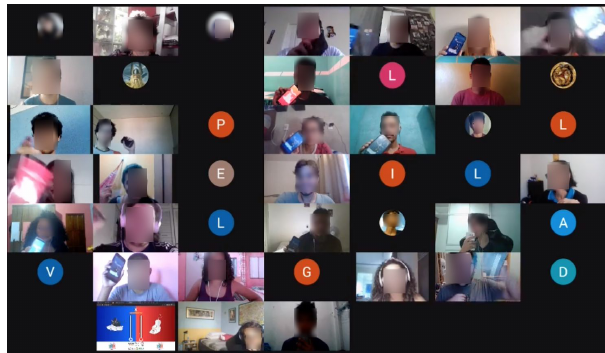
Figure 11. Students participating in the study when interacting with the